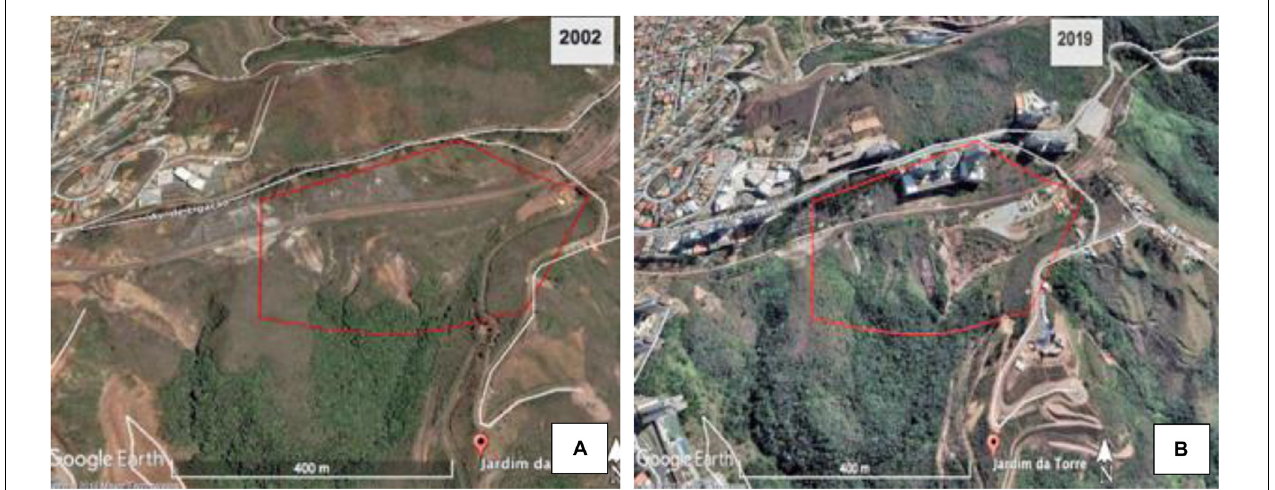
FIGURE 4 | Location of the study area (perimeter delimited in red) between Belvedere (Belo Horizonte) and Jardim da Torre neighborhoods (Nova Lima). Source: Google Earth: (A) 2002 and (B) 2019.